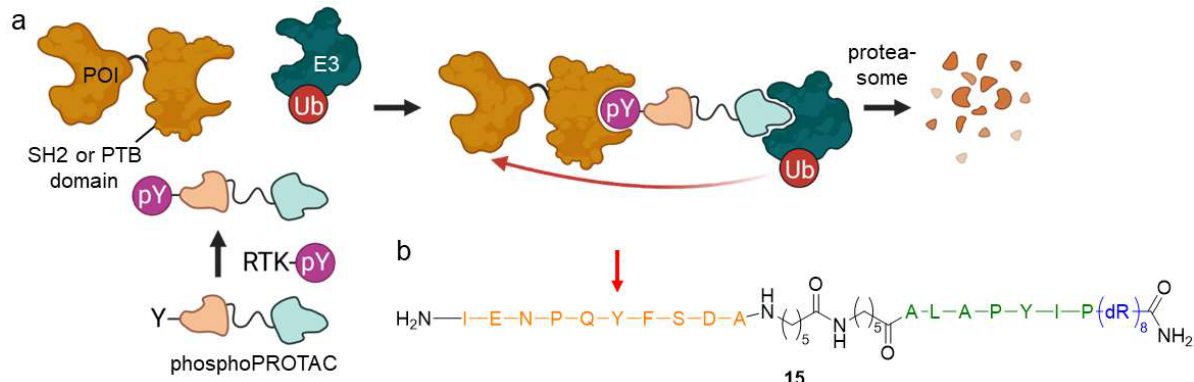
Figure 11. Phospho-dependent PROTACs (phosphoPROTACs) are controlled by the cellular phosphorylation state. ( a ) Upon phosphorylation by activated RTK, phosphoPROTACs bind to proteins containing a SH2 or PTB domain and an E3 ligase, marking the POI for proteasomal degradation. ( b ) PhosphoPROTACs are composed of a peptide sequence (orange), which can be phosphorylated at the tyrosine residue (red arrow) to bind a SH2 or PTB domain-containing protein, a spacer, a second peptide ligand for VHL (green), and a poly- D -arginine residue (blue) to enhance cell permeability.